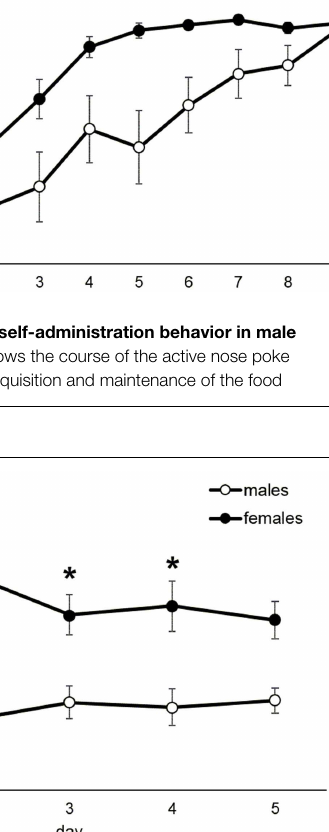
FIGURE 5 | Maintenance of food self-administration in male and female rats . The graph shows pellet intake in female rats as compared